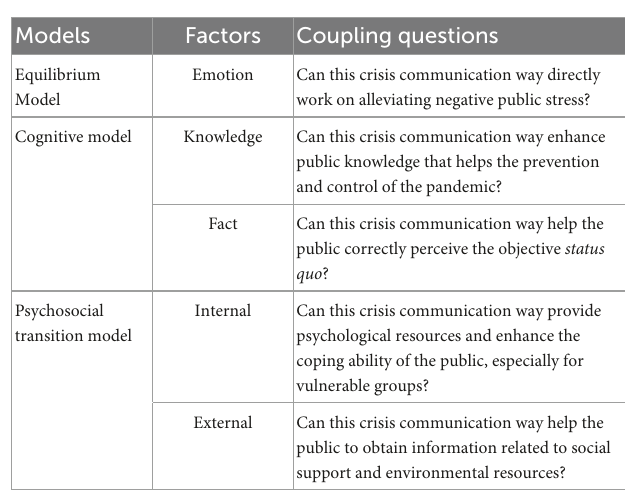
TABLE 2 Models, factors, and coupling